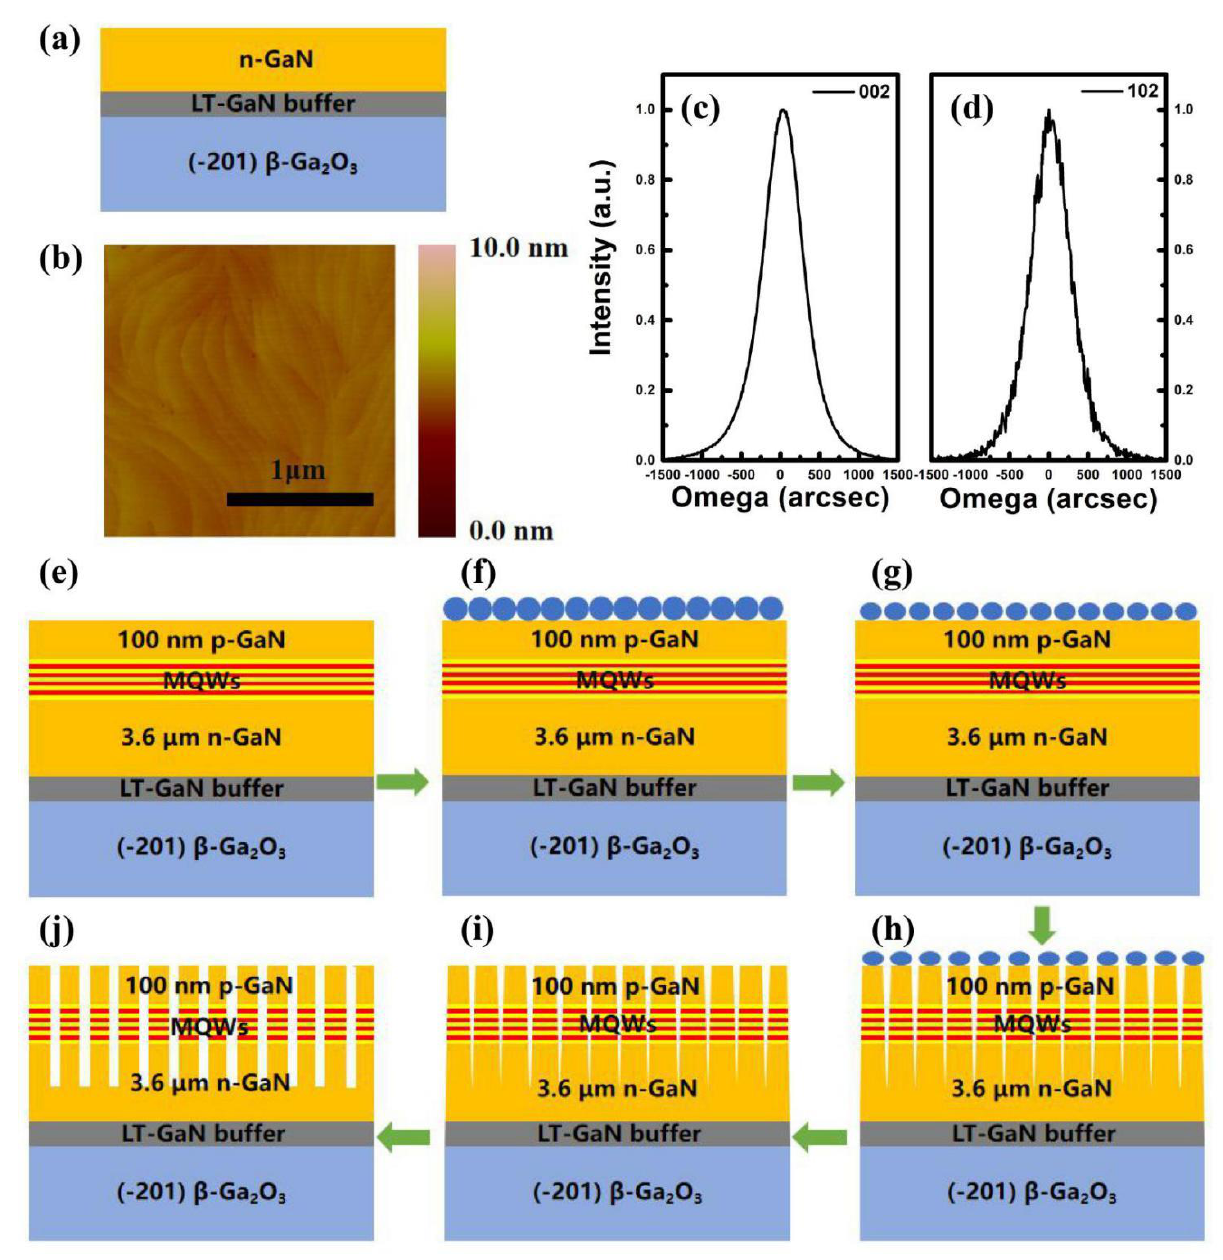
Figure 1. ( a ) The schematic diagram of the epitaxial GaN on β -Ga 2 O 3 substrate. ( b ) The AFM image of the epitaxial GaN on β -Ga 2 O 3. substrate. The normalized XRD rocking curves of the epitaxial GaN on β -Ga 2 O 3 substrate: ( c ) (002) reflection peak; ( d ) (102) reflection peak. The schematic illustrations of fabricating GaN-based nanorod LED on the β -Ga 2 O 3 substrate: ( e ) The planar LED with epitaxial grown on β -Ga 2 O 3 substrate. ( f ) Transferring self-assembly SiO 2 nanospheres on the planar LED. ( g ) Shrinking the diameter of SiO 2 nanospheres via CHF 3 -based ICP etching. ( h ) Etching GaN via Cl-based ICP etching. ( i ) Removing SiO 2 mask by BOE solution. ( j ) Removing etching damage by KOH